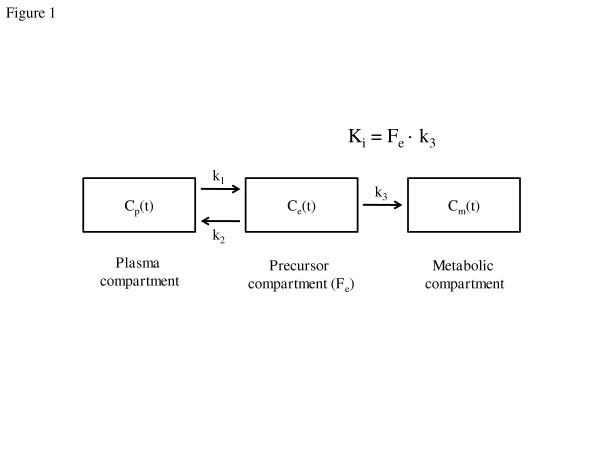
Sokoloff model for 18F-fluorodeoxyglucose tracer kinetics [13]. The three compartments of the model describe the activity concentration of 18F-fluorodeoxyglucose (18F-FDG) in plasma (Cp(t)), the region of interest (ROI) concentration of extravascular 18F-FDG serving as a substrate pool for hexokinase (precursor compartment, Ce(t)) and the ROI concentration of phosphorylated 18F-FDG (Cm(t)). The arrows indicate the tracer exchanges in the dynamic model and the corresponding parameters. The rate constants k1 and k2 account for forward and backward transport of 18F-FDG between blood and tissue. k3 is the rate of 18F-FDG phosphorylation, reflecting hexokinase activity. The constant Fe represents the distribution volume of 18F-FDG (that is, the substrate pool for hexokinase) as a fraction of lung tissue volume.